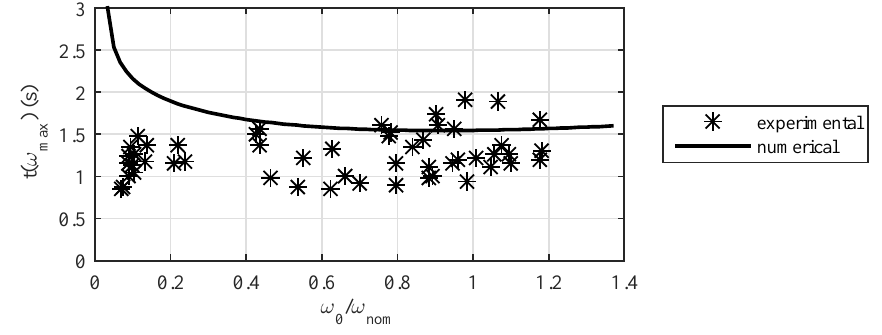
Figure 8. Time of maximum overshoot in seconds from release.